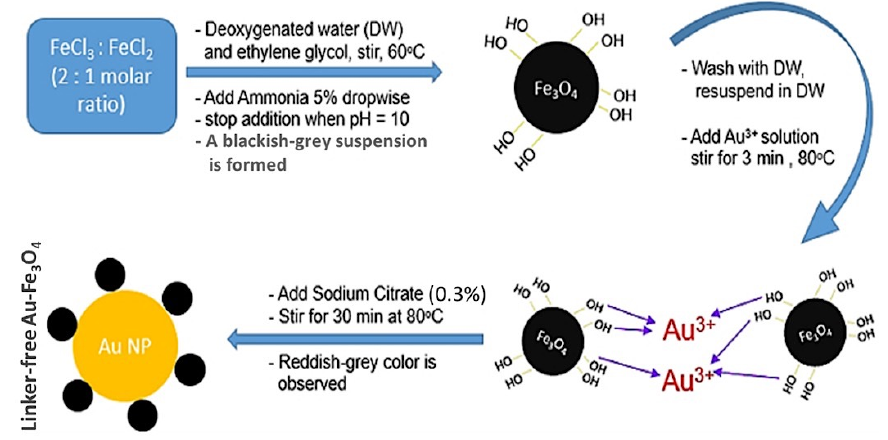
Figure 1. Schematic of Fe 3 O 4 -Au nanoparticle preparation and the suggested mechanism of its for- mation.